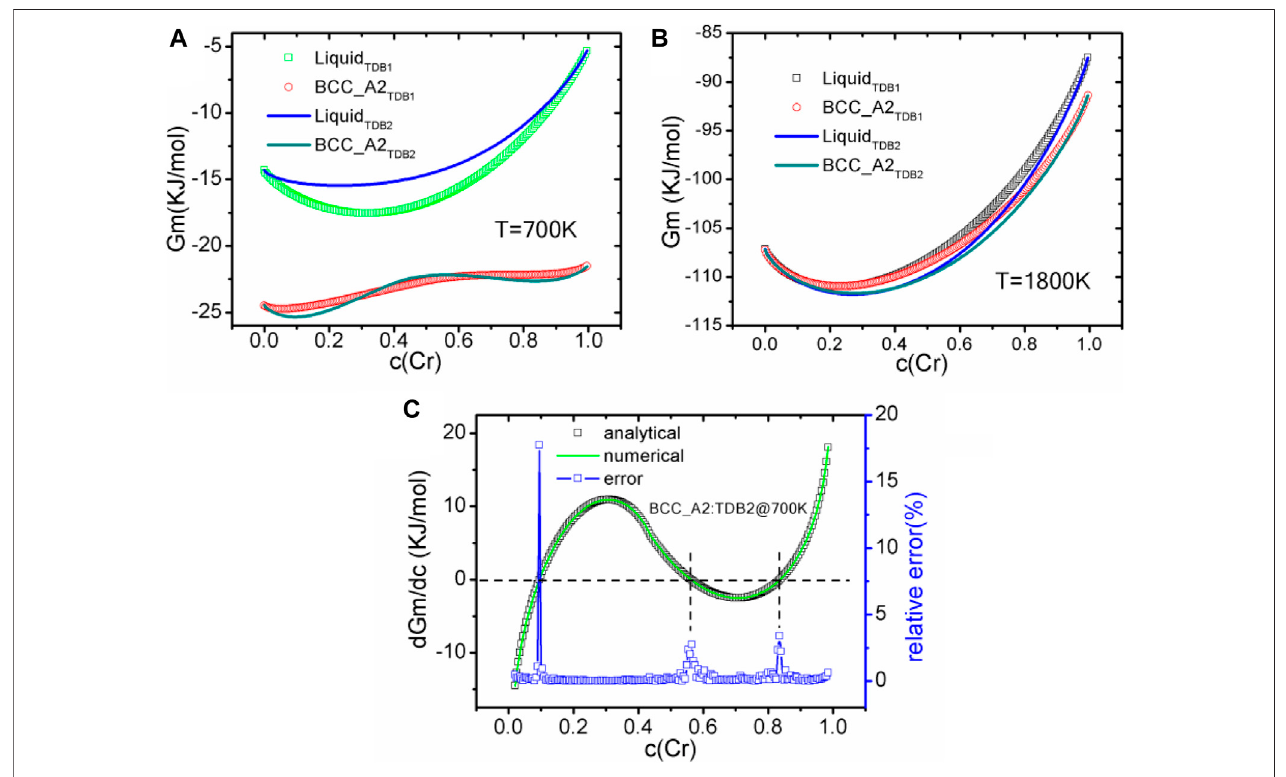
FIGURE 2 | (color online) The variation curves of liquid phase and BCC_A2 with Cr composition calculated from different TDB fi les, (A) 700 K, (B) 1800 K. (C) Comparison between diffusion potentials at 700 K calculated analytically and numerically, and the corresponding relative error (in%) of TDB2.